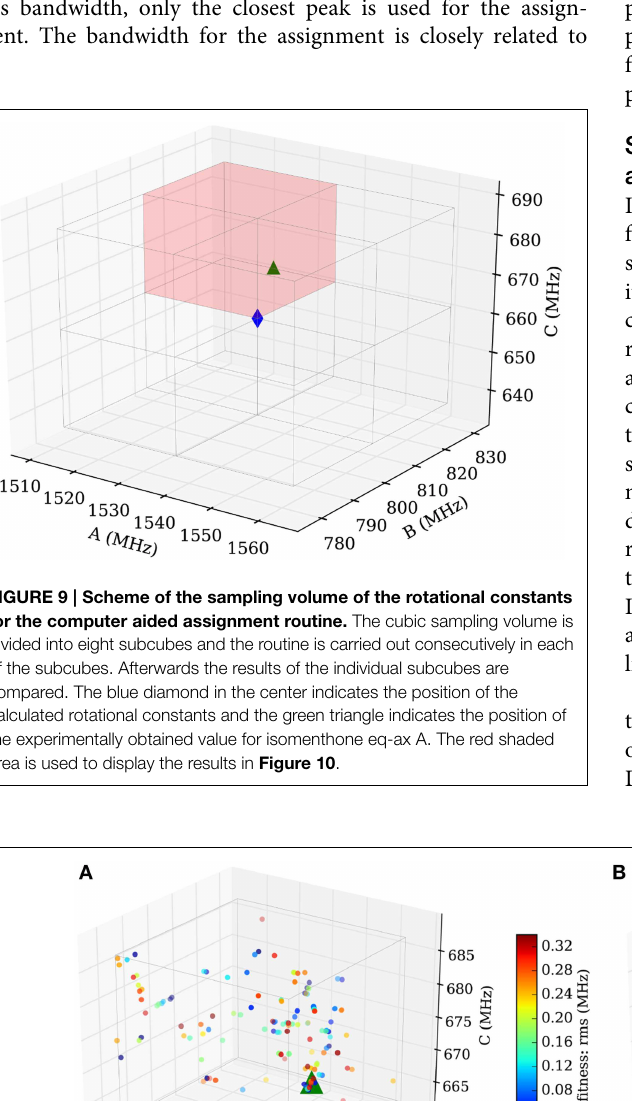
samples at the measured rotational constants and the color-code of the samples indicates a correctly assigned spectrum (up to 18 assigned transitions). The comparison of (A,B) illustrates the necessity of the evaluation step 3. Good and bad fitting results are scattered throughout the volume in (A) , but (B) reveals that the samples far away from real values predict spectra which have little overlap with the measured